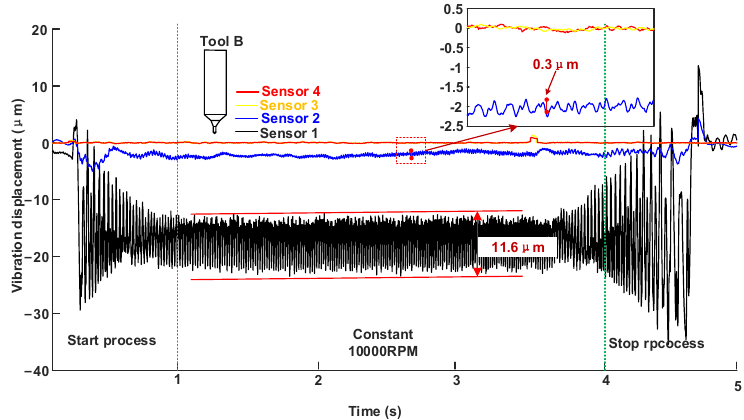
Figure 18. Vibration propagation of Tool B in start–stop process.